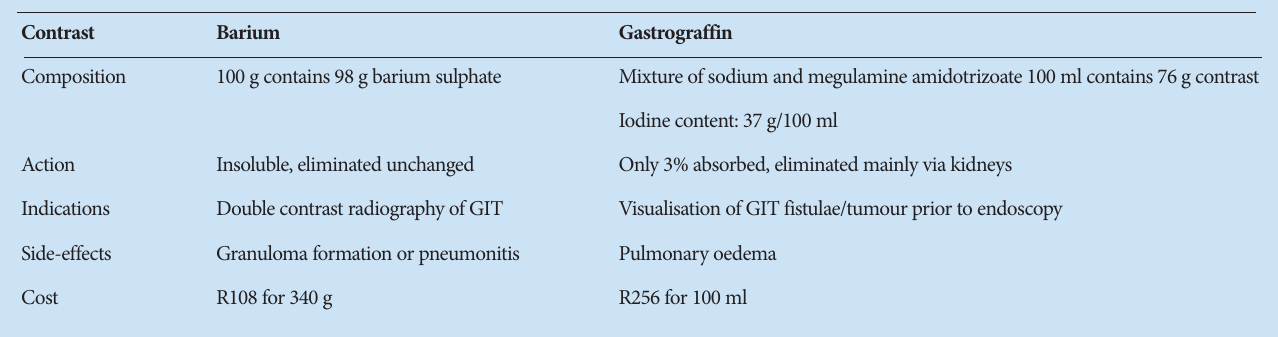
Table I. Comparison of characteristics of contrast agents